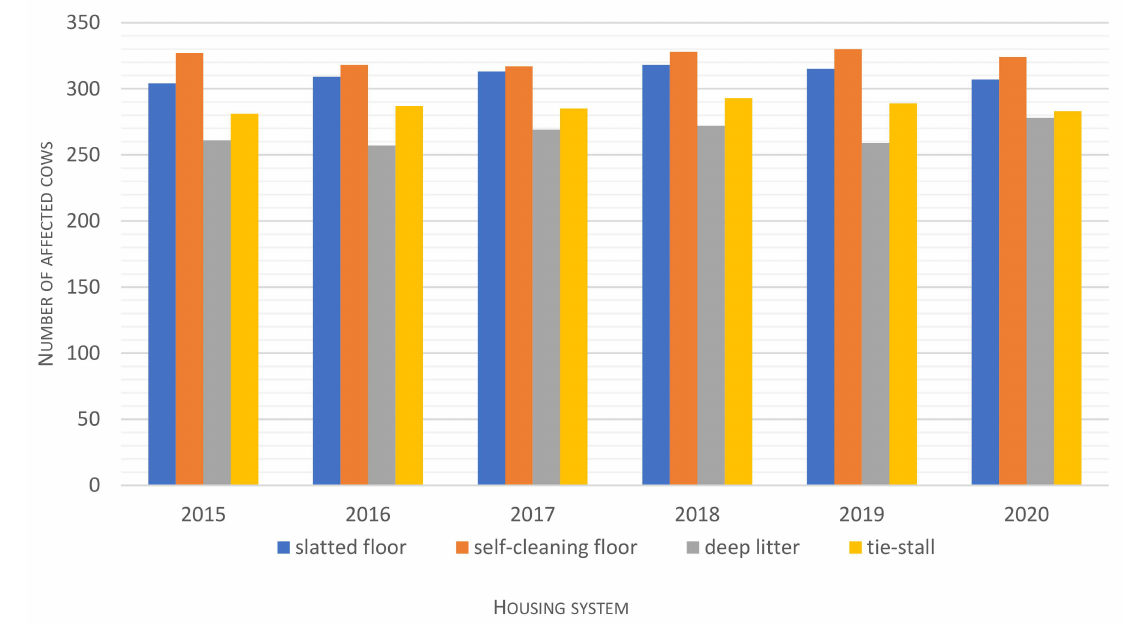
Figure 5. Average morbidity in the analyzed housing systems in each year of the study